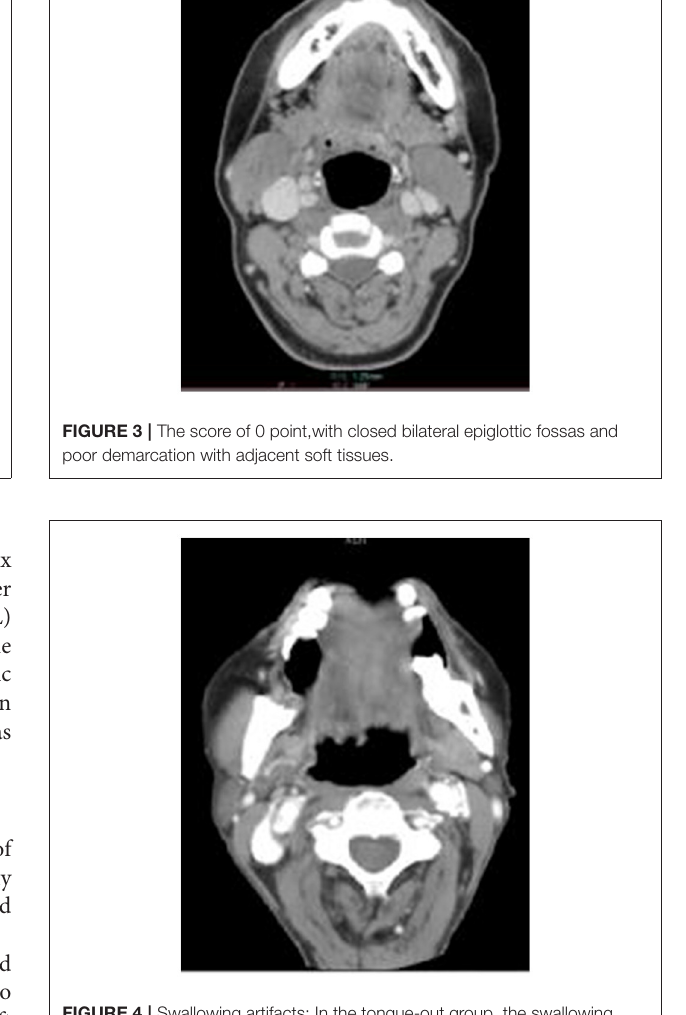
FIGURE 4 | Swallowing artifacts: In the tongue-out group, the swallowing artifacts were visible at the tongue root, with no artifacts in the cervical